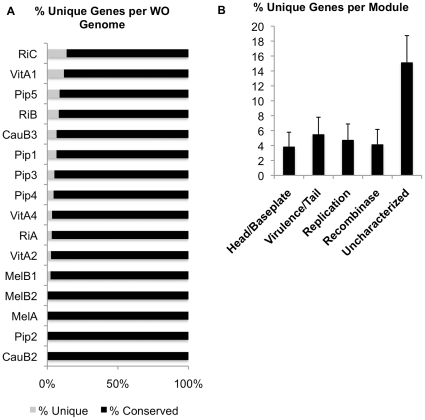
Unique genes in WO genomes are rare and scattered across functional modules.(A) The percentage of genes specific to a single prophage WO haplotype was calculated. (B) The percentage of unique genes present in each functional region across all WO prophages and standard error was identified by calculating the number of unique genes divided by the number of genes in the module.